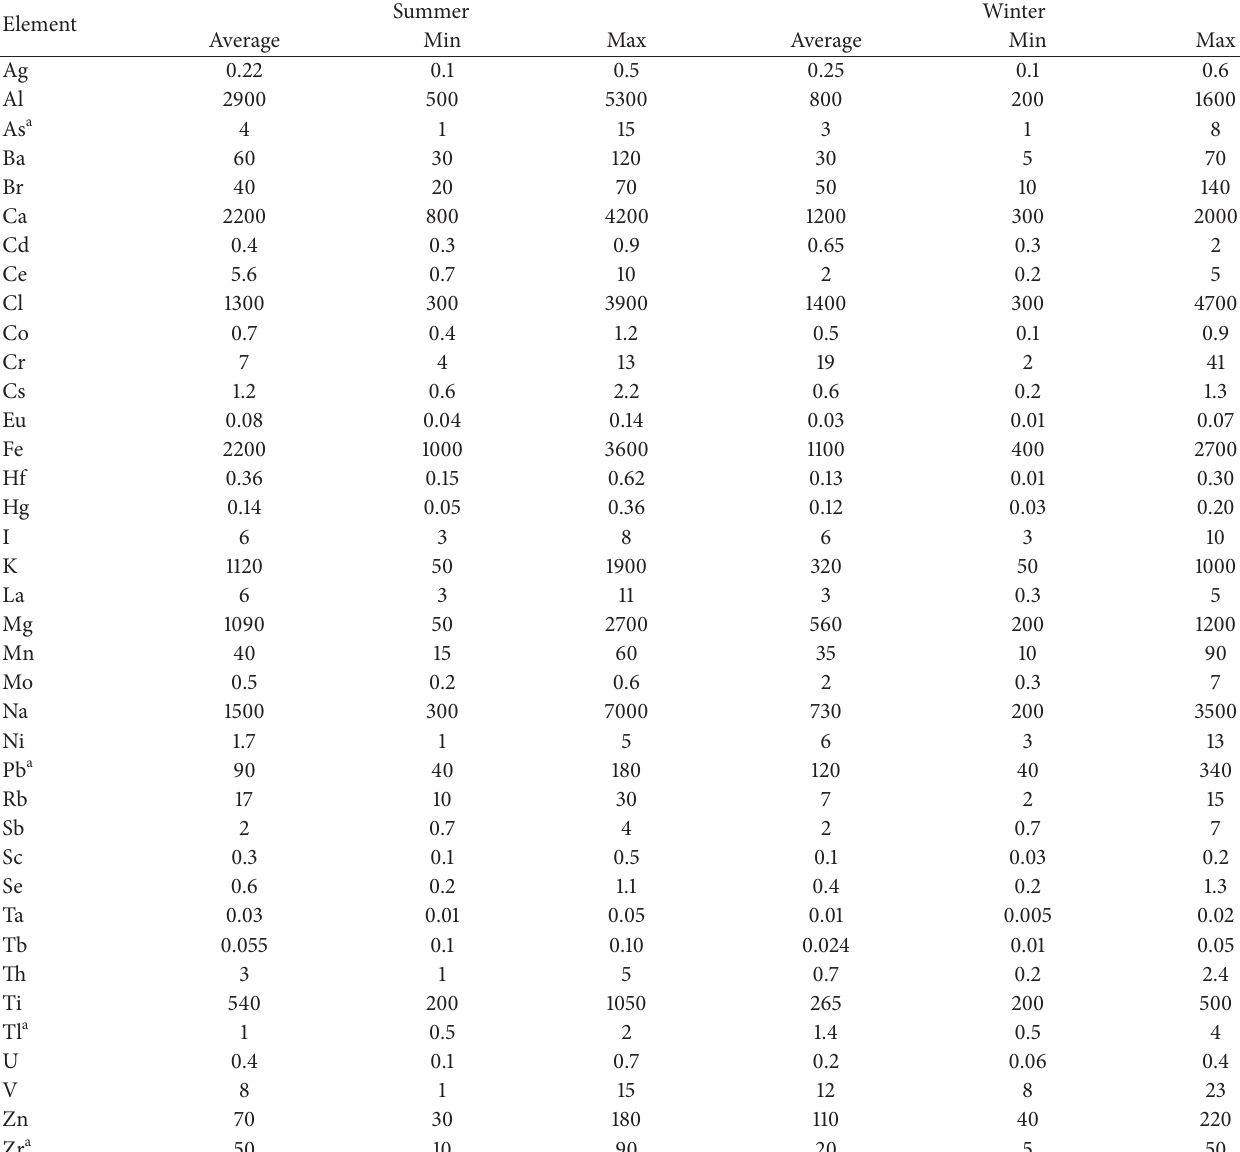
Table 3: Seasonal element concentrations (average, min, and max levels expressed as ng m − 3 ) in PM atmospheric particulate sampled in downtown Rome.